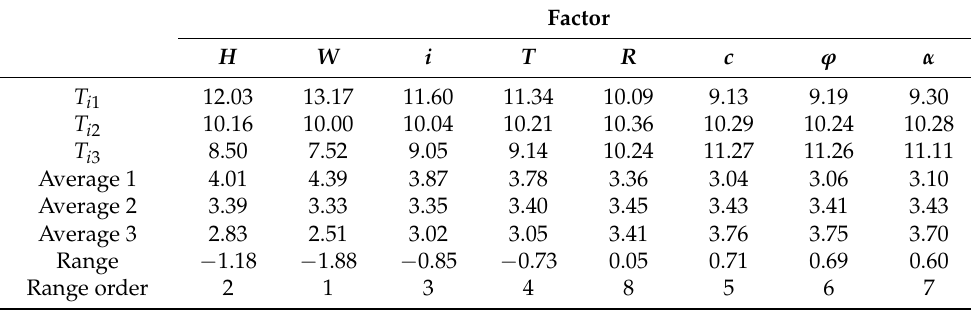
Table 11. Range analysis of the factors affecting slope stability.